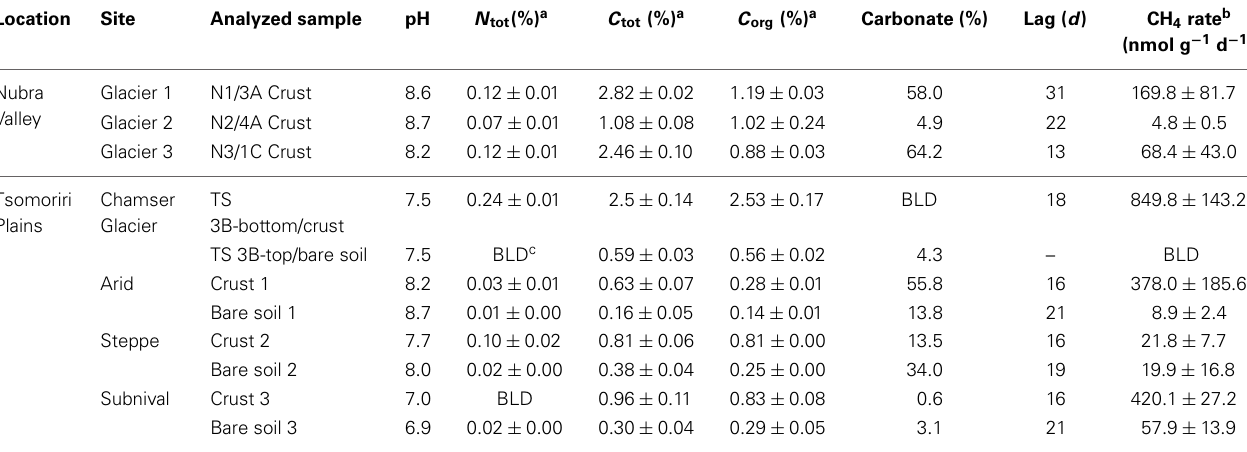
Table 1 | Physico-chemical characteristics and methanogenic potentials of a selection of the soil samples.